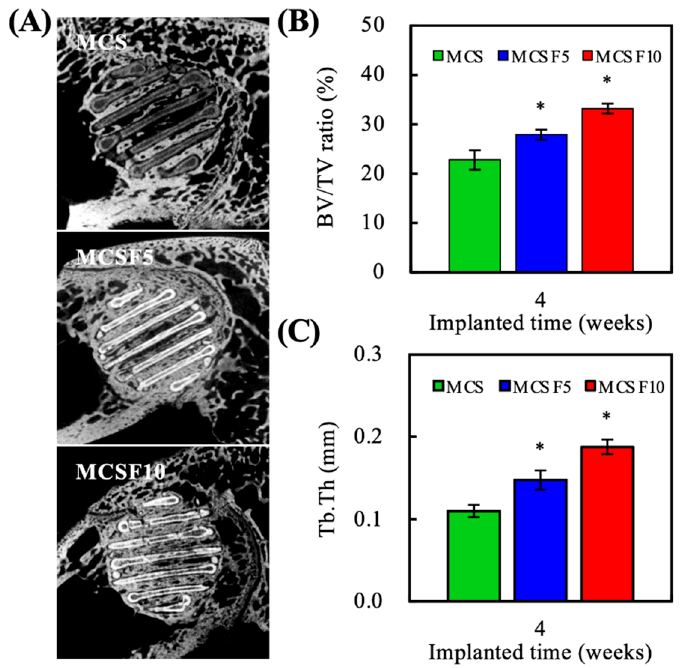
Figure 8. ( A ) The µ CT images, ( B ) data analysis of relative bone mass volume (BV / TV), and ( C Figure 8. (A) The µCT images, (B) data analysis of relative bone mass volume (BV/TV), and (C) quantitative measurement of trabecular thickness (Tb.Th) of the femur defects after implantation with different 3D printed scaffolds for 4 weeks. * indicates significant difference (p < 0.05) from MCS group.